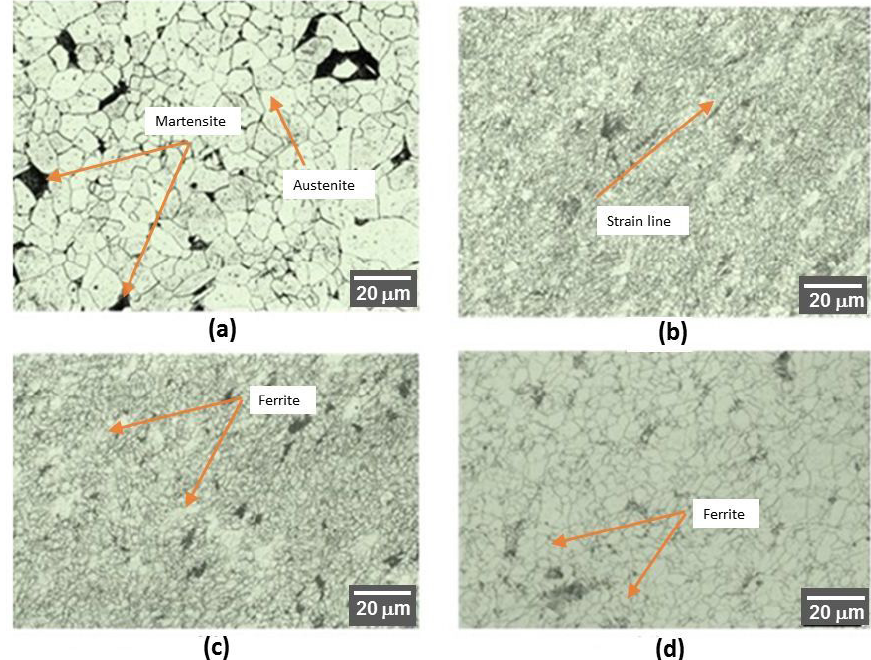
Figure 10. Low carbon steel at 800°C, 200X (a) Alone quenched, (b) strain rate 0.1 s -1 , (c) 0.01 s -1 and (d) 0.001 s -1 .